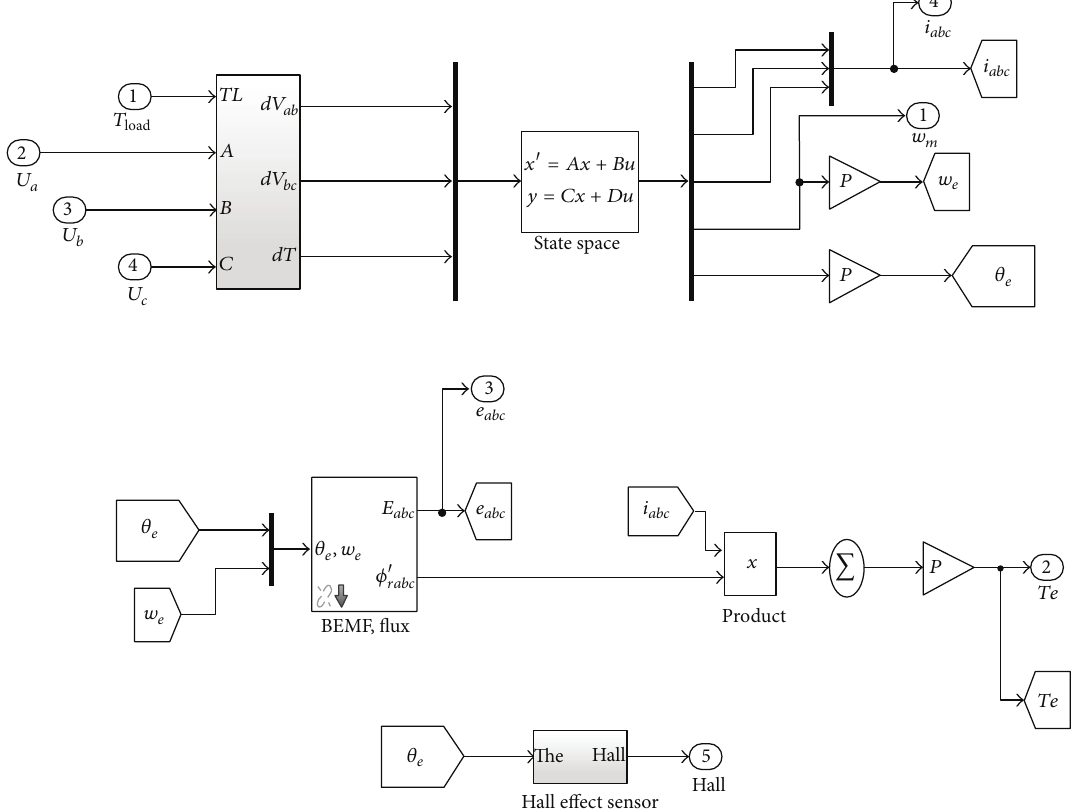
Figure 2: Mathematical model of BLDC motor in state space